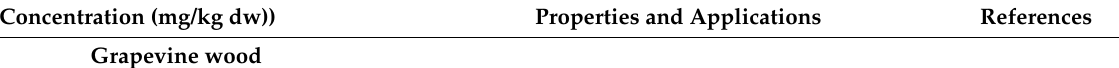
Table 2. Main bioactive compounds (mg/kg dry wood) from grapevine wood and their applications. * n.d.: not detected. ** ↑ : Increase. Chemical structures by families are shown in Figure